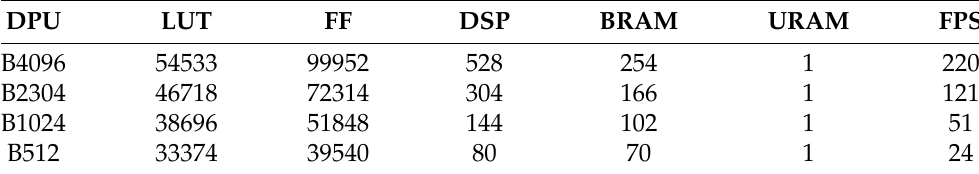
Table 4. Occupation of resources and throughput for different architectures of the DPU running the inference of